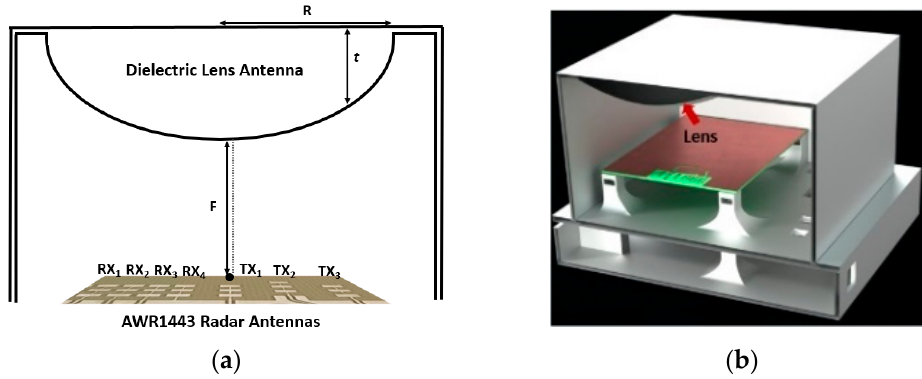
Figure 1. ( a ) Schematic of the in-package dielectric hyperbola-based lens antenna integrated with the AWR1443Boost radar, ( b ) Cross-view of 3D model of the designed system in SolidWorks with the radar/lens cover showing the encapsulated lens. TXs: transmitters, RXs: receivers.